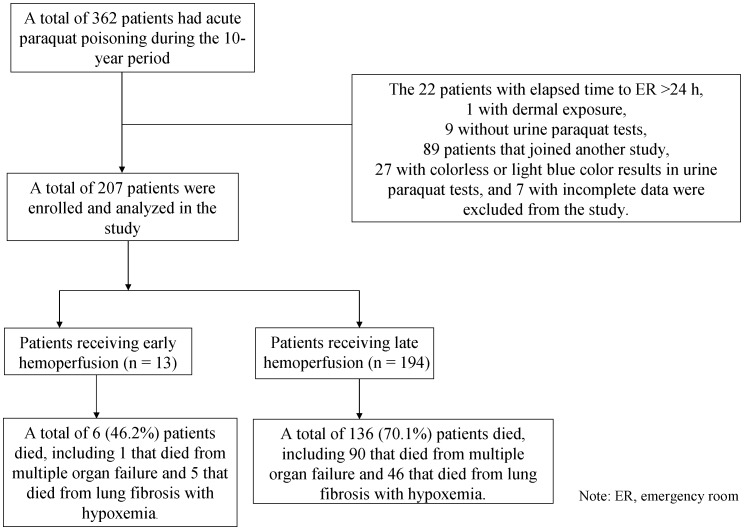
Overview of the study design, showing the enrollment and status of the patients.